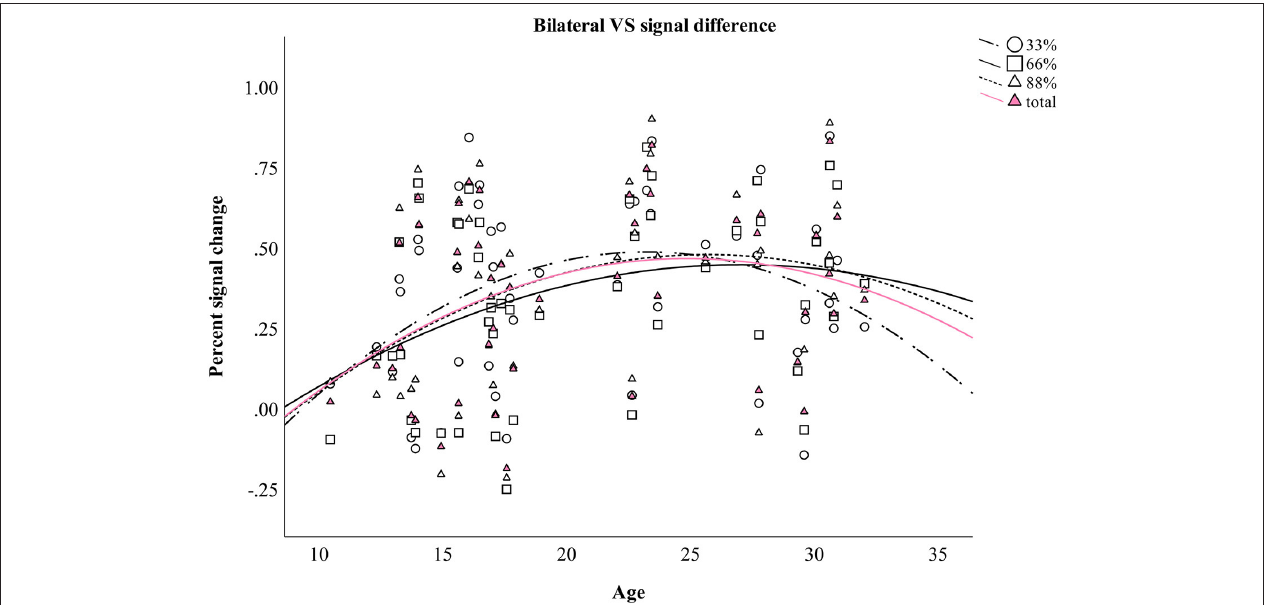
FIGURE 4 | Difference between monetary and verbal condition in the percent signal change in bilateral VS during aging. Individual values as well as regression curves against age are depicted for bilateral VS.